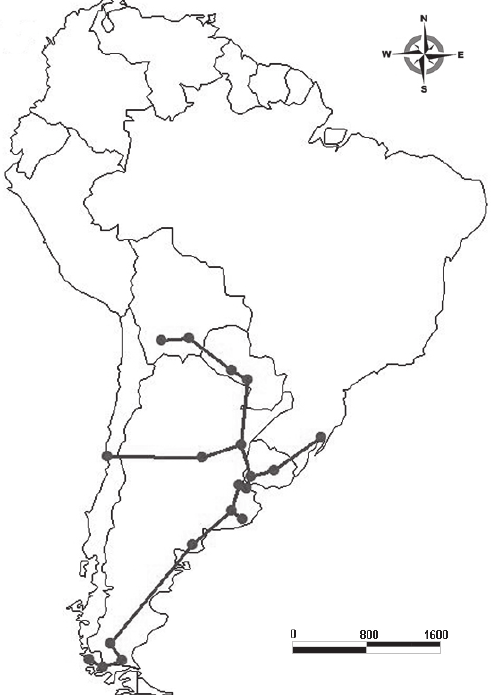
Fig. 12 - Individual track of Macrauchenia patachonica .